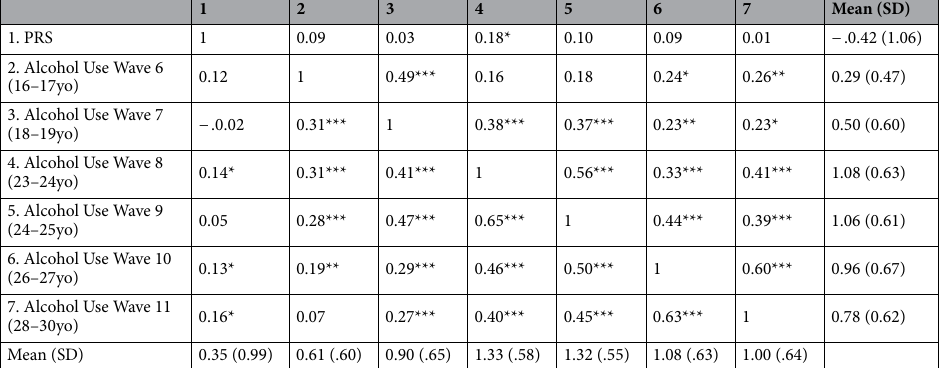
Table 1. Correlations, means, and standard deviations among polygenic risk scores and alcohol use for african americans above the diagonal and european americans below the diagonal. PRS polygenic risk score. Standardized PRS and log transformed alcohol use scores are presented. * p < .05, ** p < .01, *** p < .001.